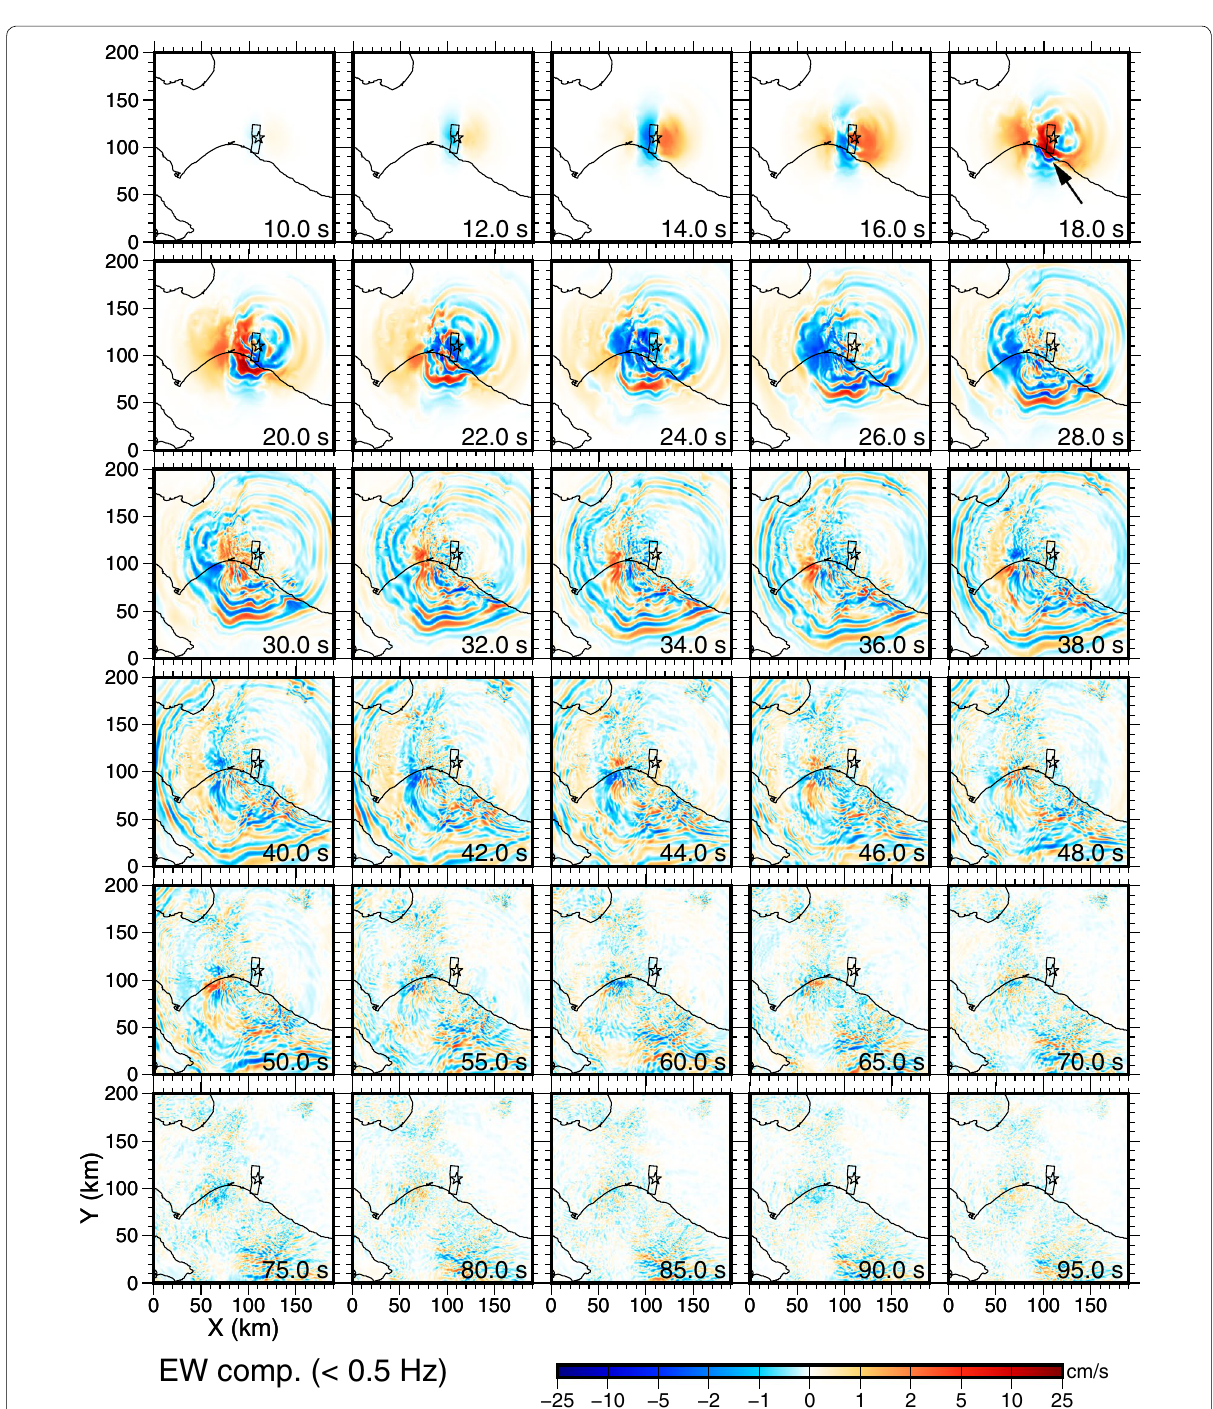
Fig. 9 Snapshots of the simulated seismic wave propagation in the EW (east–west) component, low-pass filtered at 0.5 Hz. The open star and rectangles show the epicenter and the surface projection of the source fault,